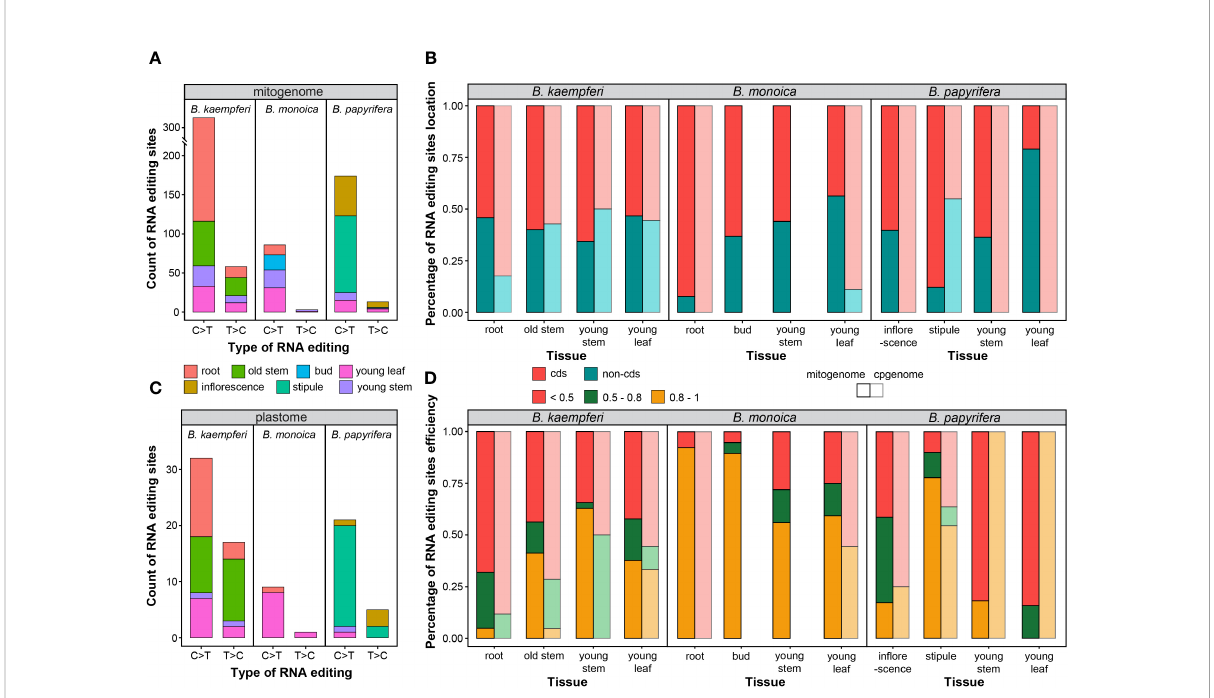
FIGURE 6 RNA editing type and ef fi ciency. (A) Count of RNA editing site across mitogenome in each tissue. (B) Percentage of RNA editing site location in each tissue. (C) Count of RNA editing site across plastome in each tissue. (D) Percentage of RNA editing ef fi ciency in each